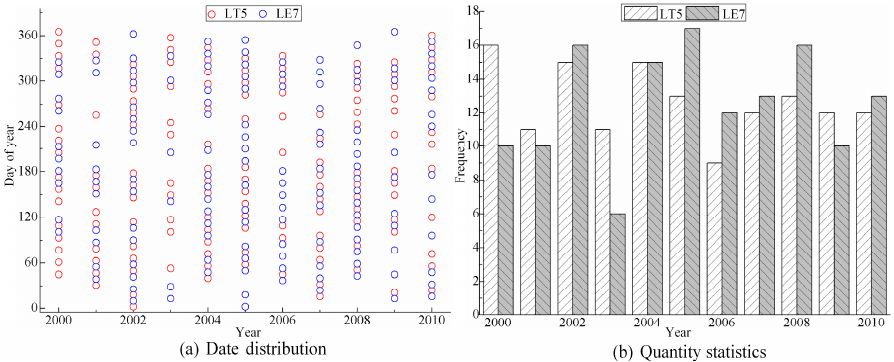
Figure 5. All available Landsat images from 2000 to 2010. ( a ) Day of year distribution, and ( b ) the quantity statistics of Landsat images for each year. Table 1. Pseudo-invariant samples and cross-validation samples.